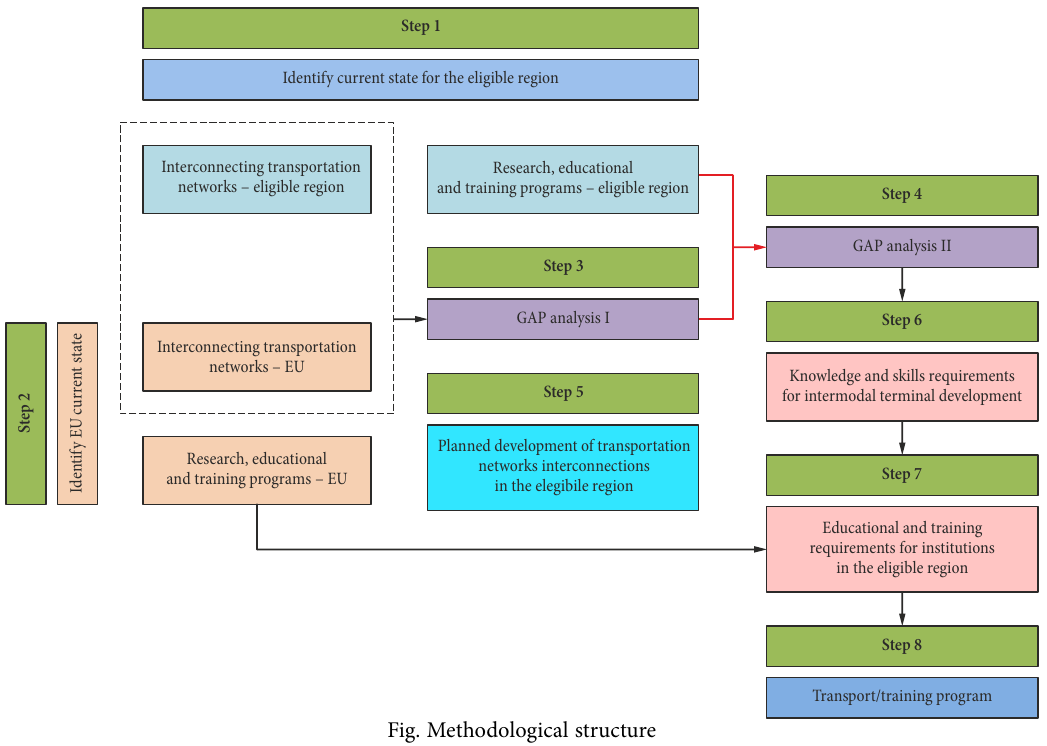
Fig. Methodological